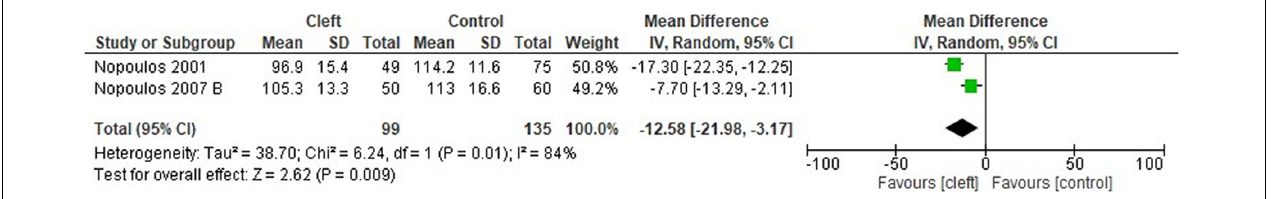
FIGURE 8 | Forest plot for full-scale IQ